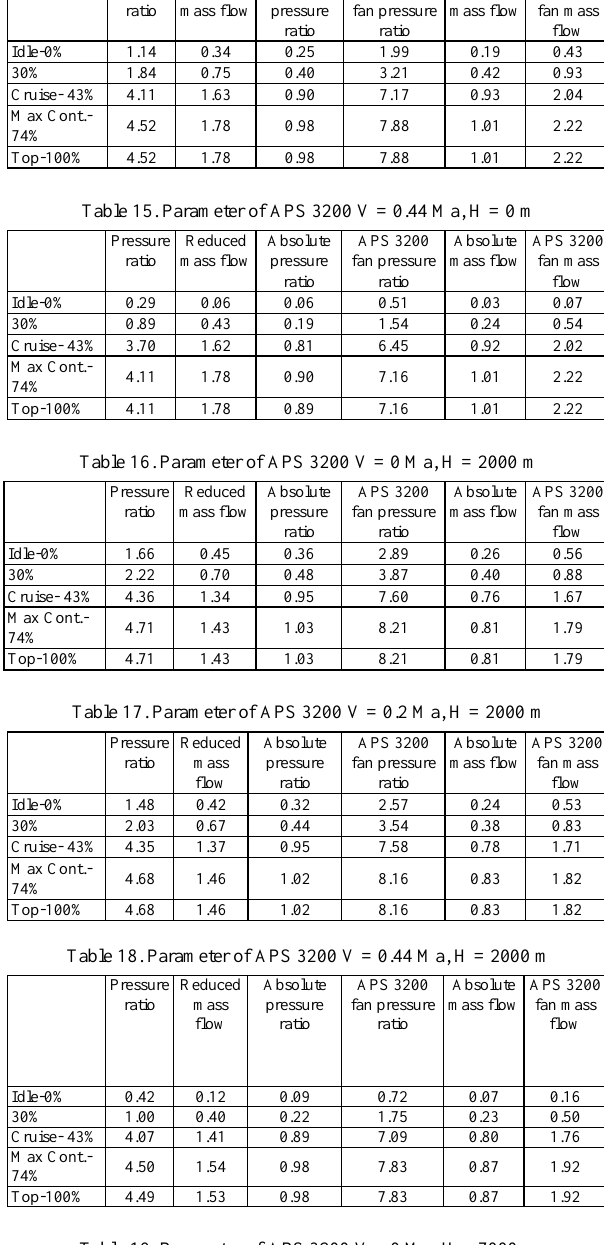
Table 11. Parameter of CFM 56-5B V = 0.2 Ma, H = 7000 m Pressure ratio